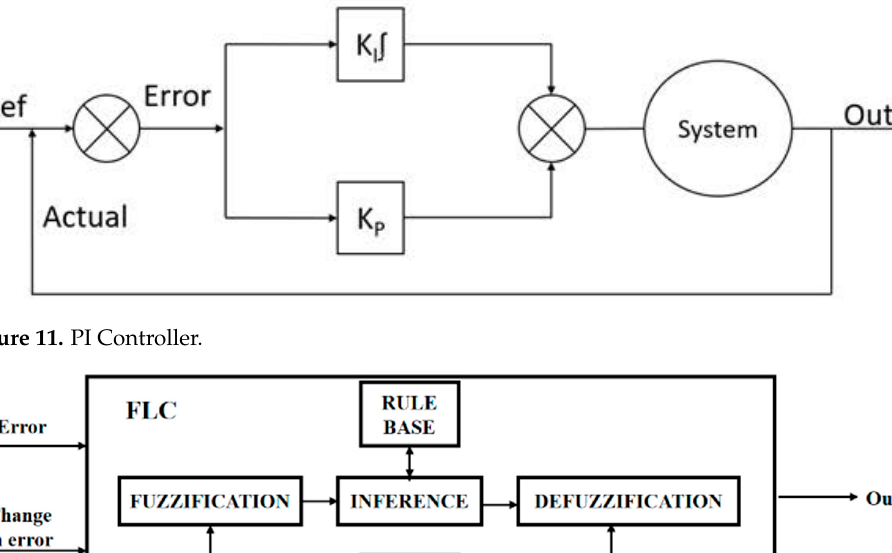
Figure 12. Block diagram representation of FLC.